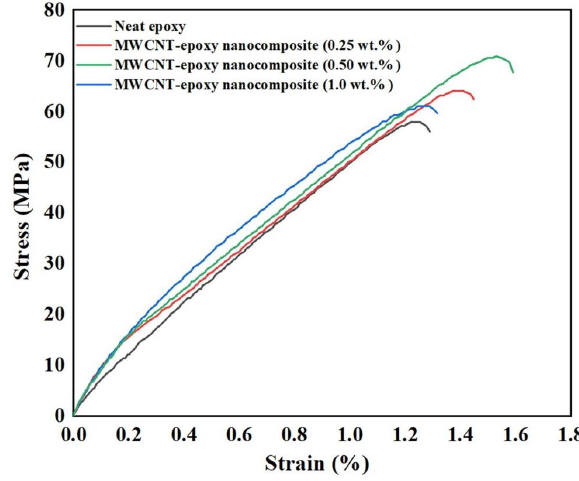
Figure 4: Stress-strain curves of neat epoxy and epoxy nanocompos- ites with different weight percentages of MWCNTs